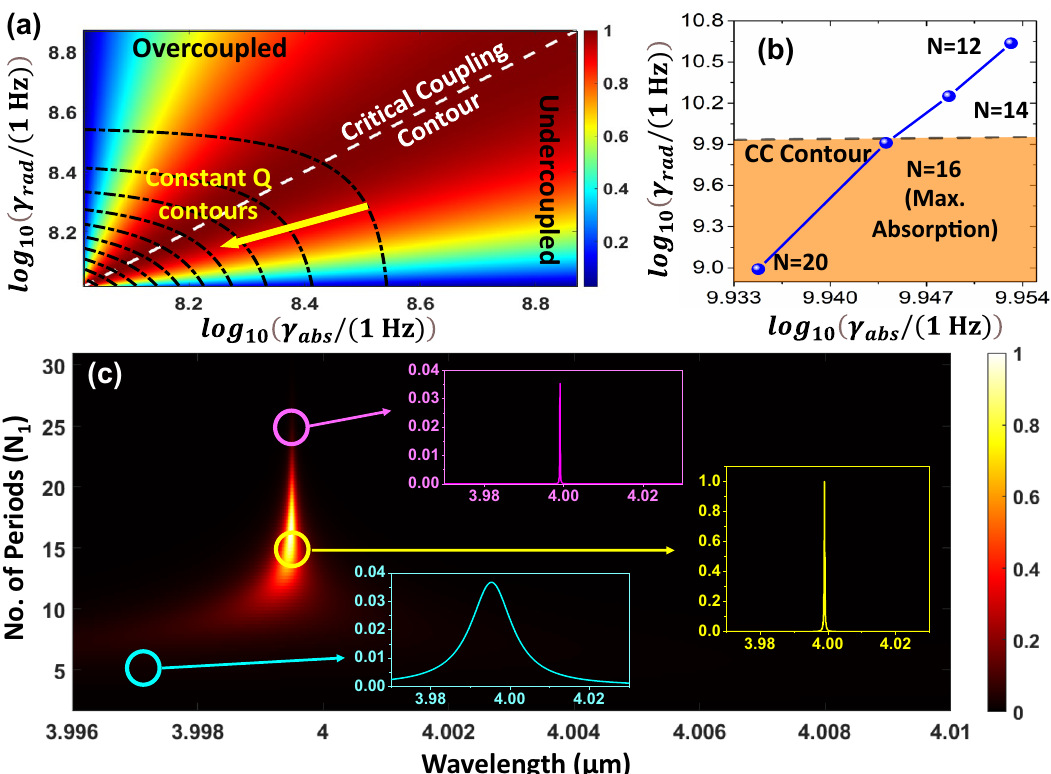
Figure 5. ( a ) TCMT parameter space and notions of absorption optimization for a single mode leaky resonator; ( b ) extraction of perfect absorption operating point in our one-port emitter using TCMT; ( c ) validation of TCMT predictions using TMM and calculated absorption